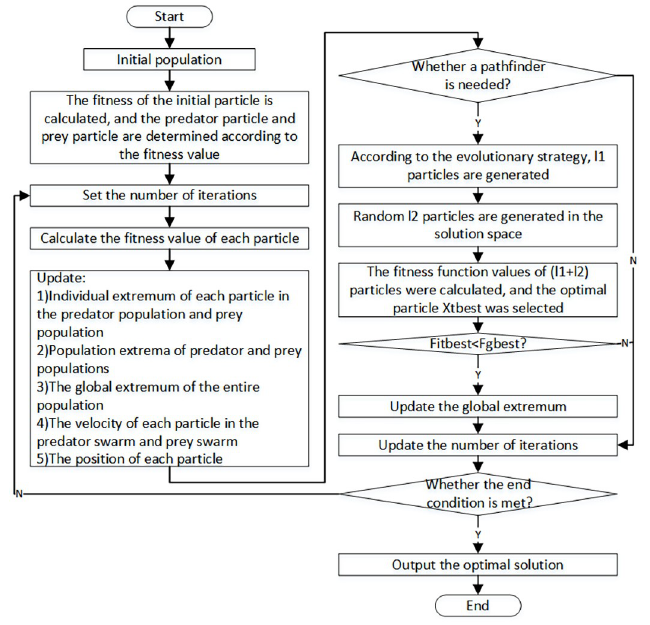
Fig 4. Improved predator-prey particle swarm optimization flow